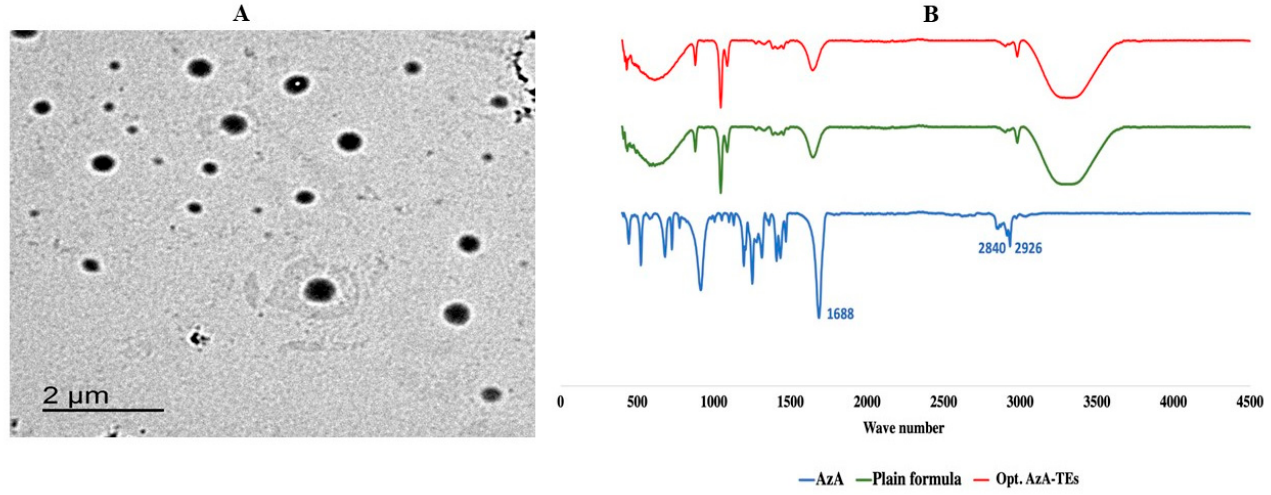
Figure 2. Characterization of the optimized formula; ( A ) Transmission electron microscopy of the optimized AzA-TEs; ( B ) FTIR spectra of the free AzA, plain formula, and optimized